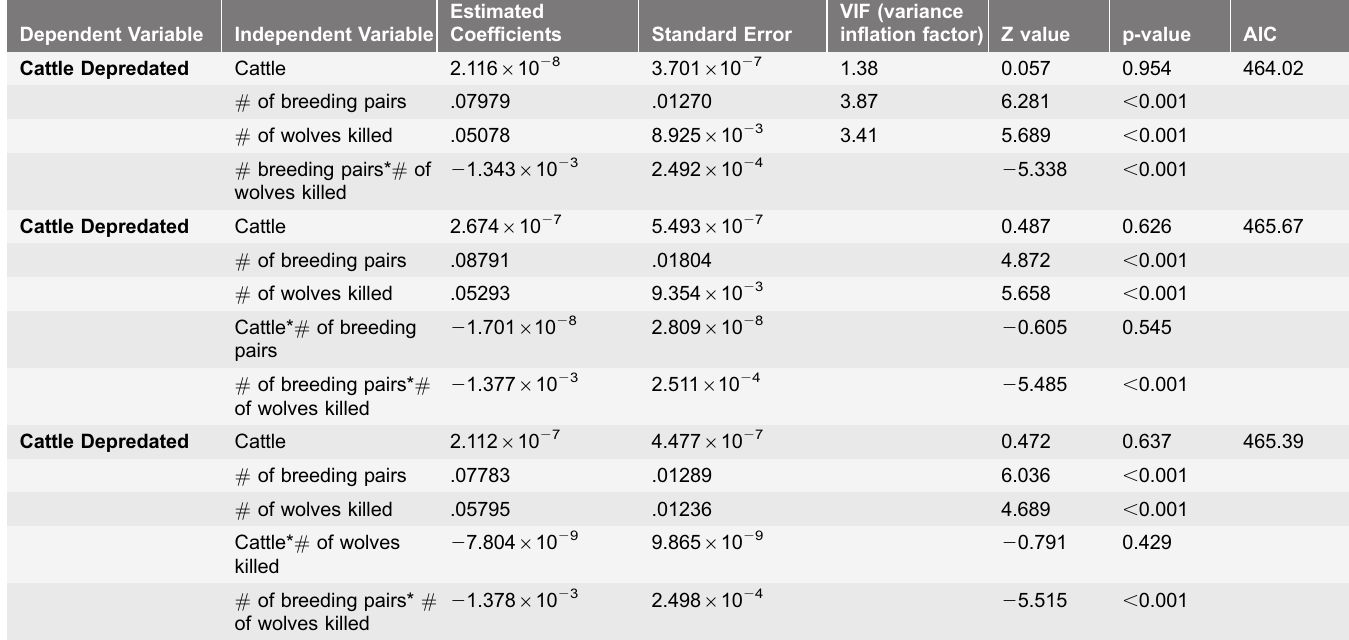
Table 2. Summary of best model for cattle depredated.